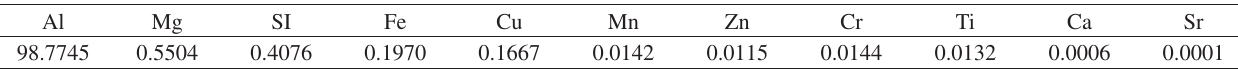
Table 1. Chemical composition of the wrought (6063) aluminium alloy (in wt. (%)). Al Mg SI